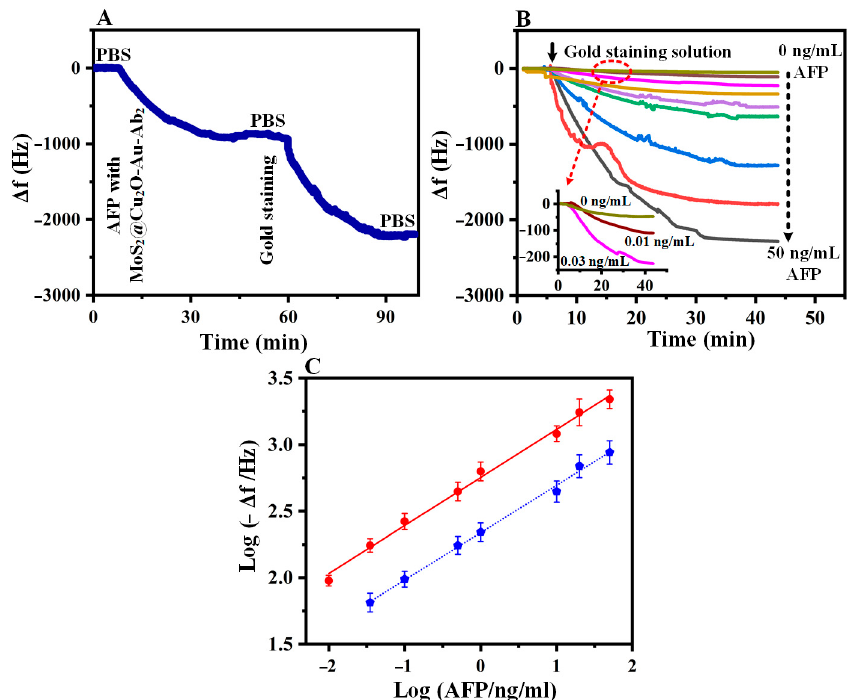
Figure 6. Real-time detection of AFP ( A ); frequency shifts observed upon injection of gold staining solution (after the injection of AFP solution mixed with MoS 2 @Cu 2 O-Au-Ab 2 conjugates) at varying concentrations from top to bottom in the order of 0, 0.01, 0.03, 0.1, 0.5, 1.0, 10, 20, and 50 ng/mL of AFP. The inset shows the magnification of the curve for 0, 0.01, and 0.03 ng/mL concentrations of AFP ( B ); frequency shifts observed as a function of AFP concentration with (solid line) and without gold staining (dotted line) on a log-log coordinate ( C ).